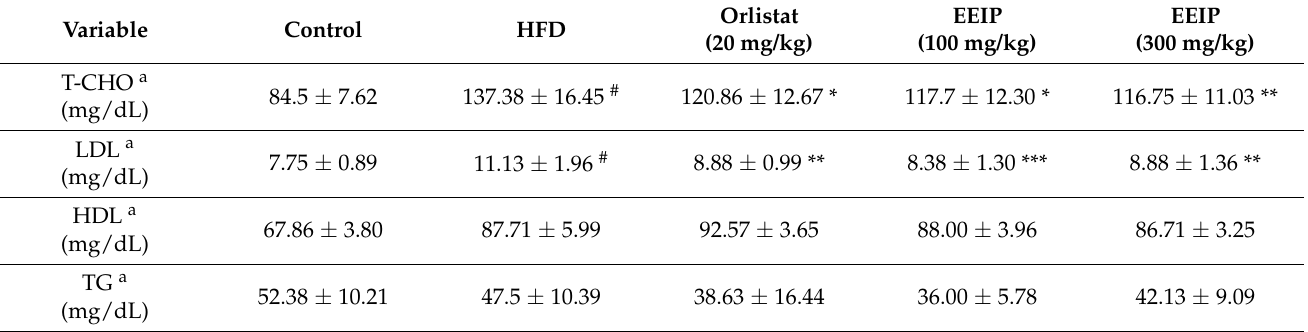
Table 2. Effect of EEIP pre-administration on the plasma level of lipid profile in HFD-fed obese